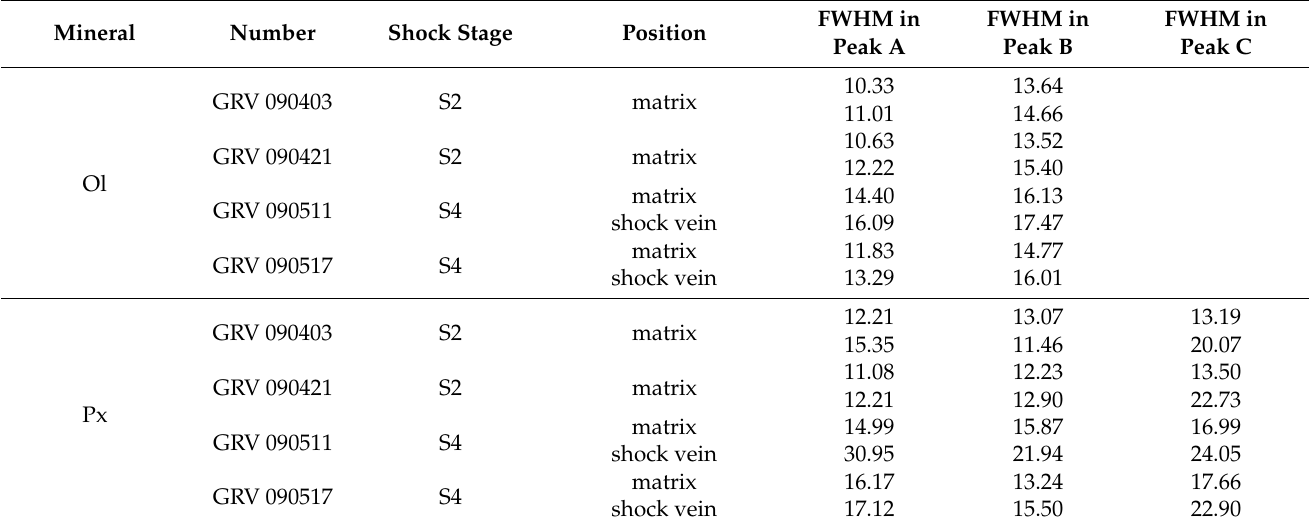
Table 3. Comparison of the FWHM of the Raman spectra of minerals in different positions of selected